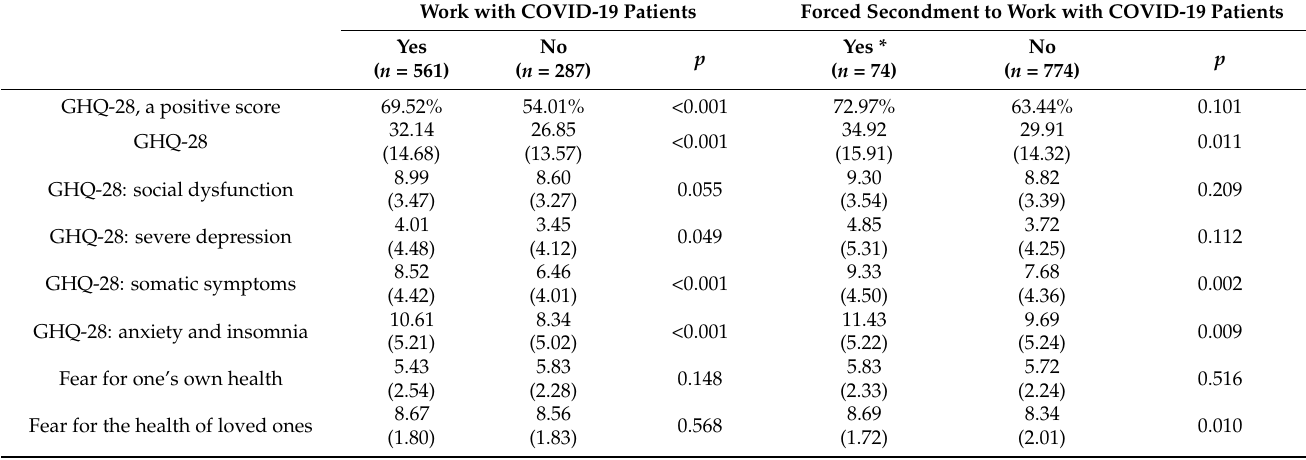
Table 3. The assessment of the effect of work in the COVID-19 fight and secondment to fight the pandemic on the GHQ-28 scale scores, and the subjective feeling of